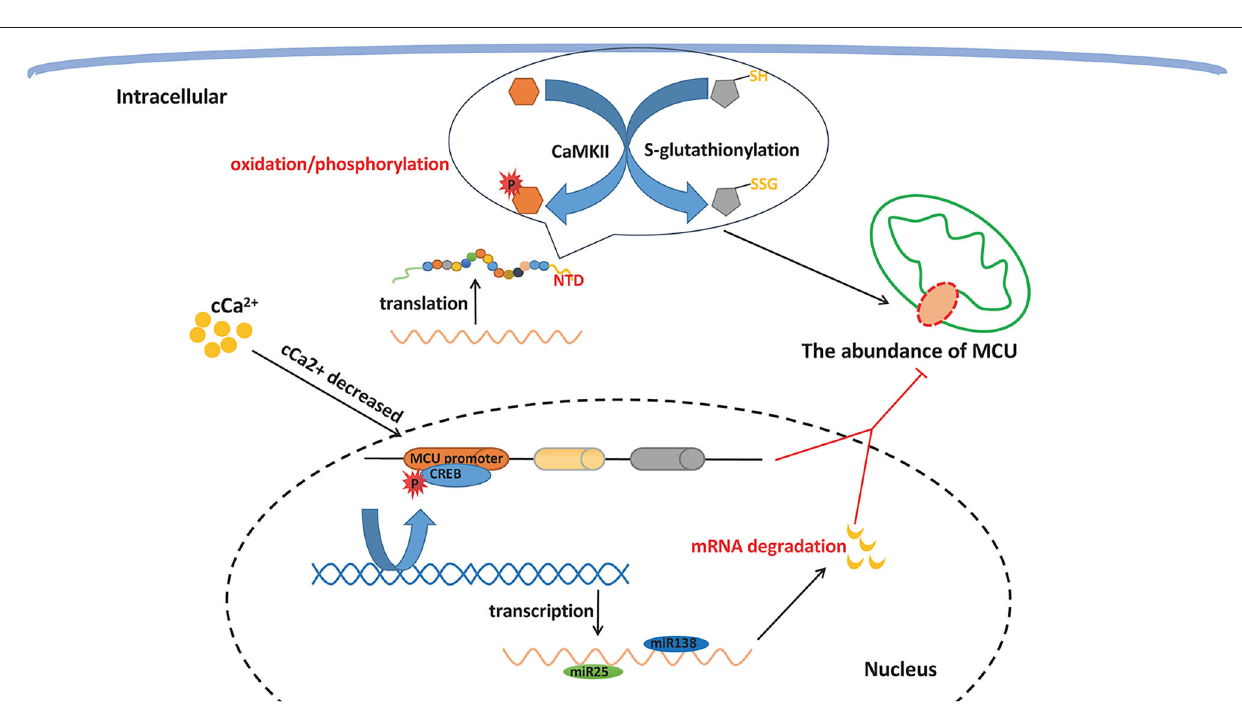
FIGURE 2 | MCU expression regulation. MCU protein generation can be impacted at several molecular levels, including transcription, post transcriptional modification, translation, and post translational modification, which can remarkably change the interplay between cCa 2 + and mCa 2 + via influencing the expression level of